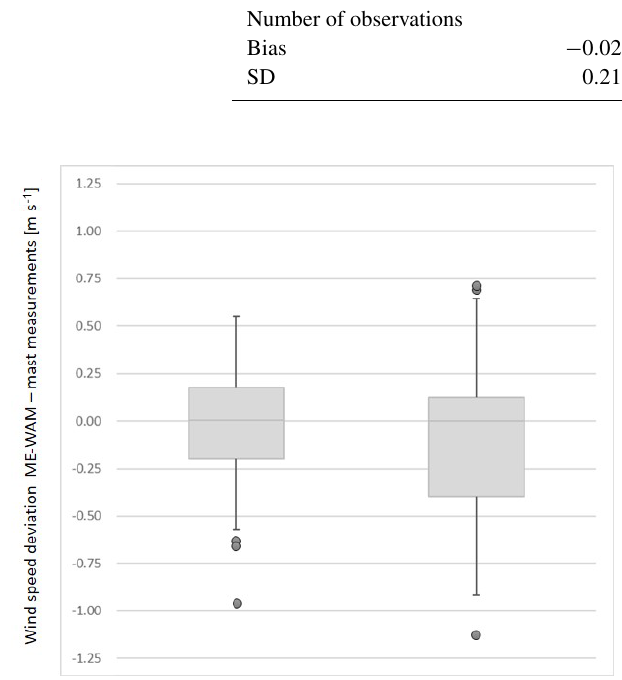
Figure 8. Box plot of the derived statistics for ME-WAM with MTLA (left) and without MTLA